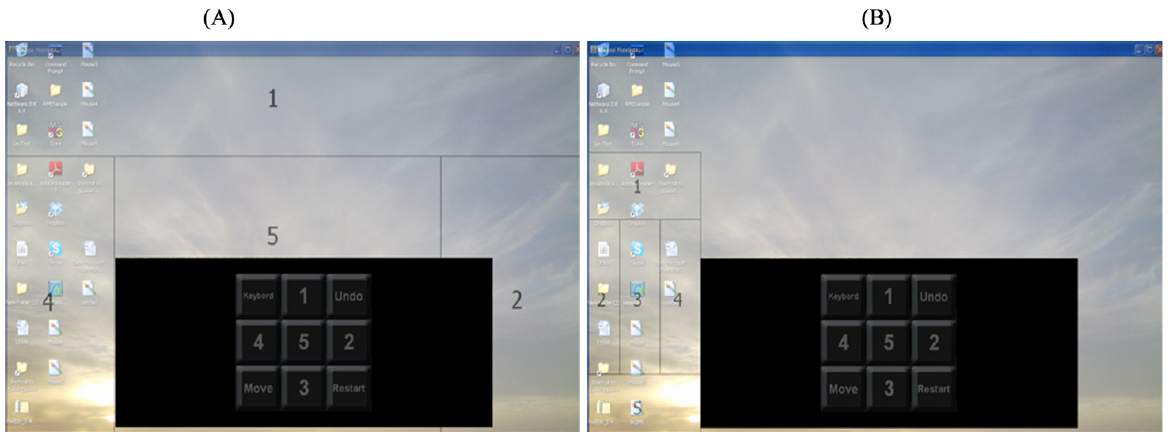
Figure 4. Dividing the user’s screen. ( A ) Successive division of the user’s screen into small areas. ( B ) Division the user’s screen into 5